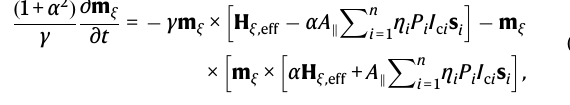
injectionofspinHallcurrenttoMn 3 Snisnegligible.AsshowninFig.3a, d,bothMgO(3)/Mn 3 Sn(12)andTi(2)/Mn 3 Sn(12)showevidentAHEwith ρ